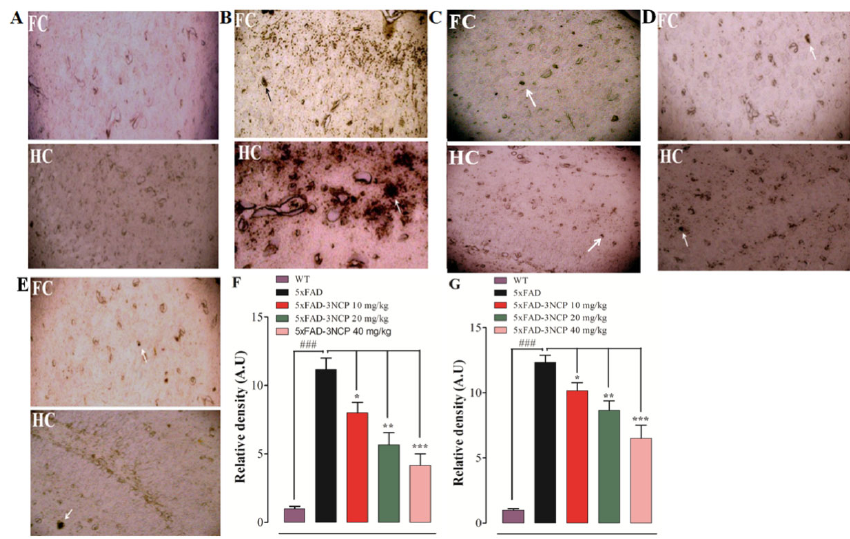
Figure 7. The protective effects of 3NCP on A β plaques in the HC and FC of the 5xFAD mice model. Neuritic plaques were detected using an anti ‐ A β antibody 4G8 and were developed using the ABC and DAB methods. FC and HC regions of; non transgenic wild type mice treated with vehicle ( A ), transgenic 5xFAD mice treated with vehicle ( B ), and 3NCP (10, 20, 40 mg/kg) treated 5xFAD mice ( C – E ), and the relative density of A β plaques in FC ( F ) and HC ( G ). The data were analyzed by one ‐ way ANOVA followed by a post hoc Tukey’s analysis. * p < 0.05, ** p < 0.01, *** p < 0.01 compared to the 5xFAD ‐ mice, ### p < 0.001 as compared to WT ‐ mice.